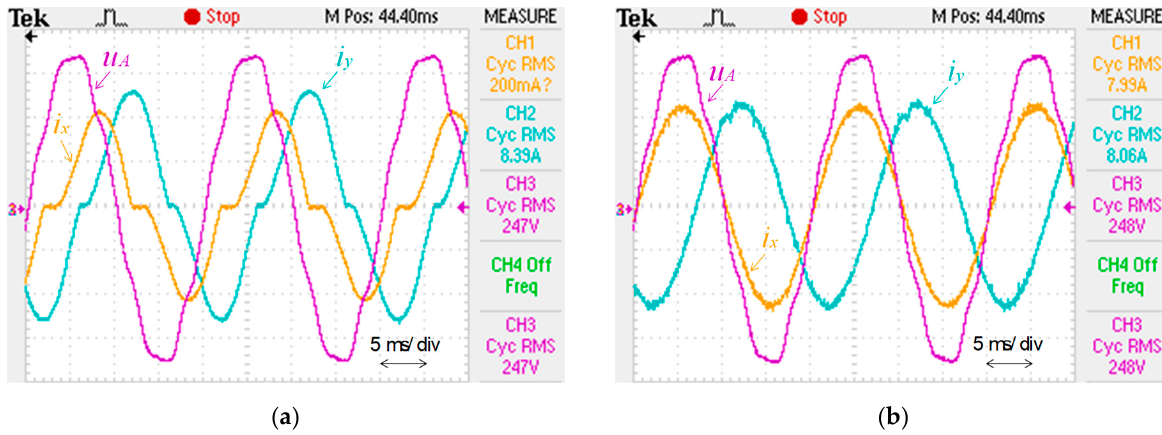
Figure 19. Experimental results when two load sections are loaded: ( a ) before compensation; ( b ) after compensation. Phase x current ( i x : 5 A/div); phase y current ( i y : 5 A/div); phase A voltage ( u A : 100 V/div).